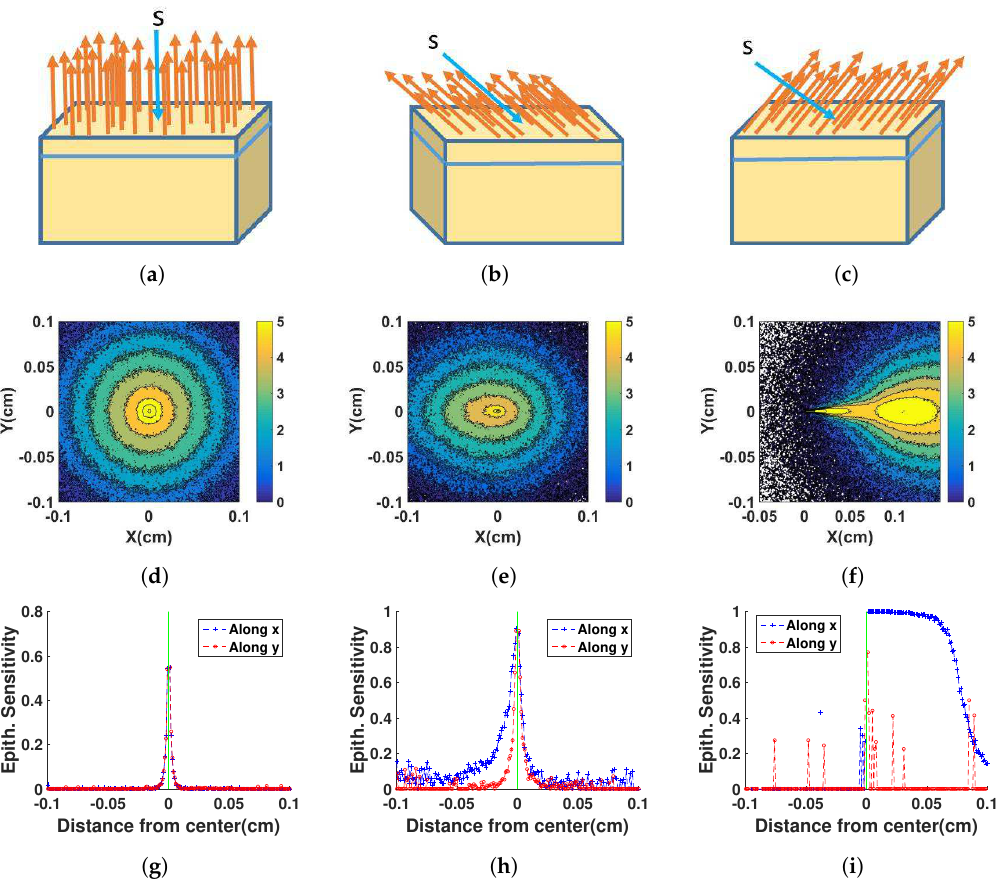
Figure 2. probe geometry-( a ) I, ( b ) II, and ( c ) III. In each of the three geometries, the blue arrow shows the launching direction of photon and orange arrows indicates the axis of collection of photons for SRR measurement. ( d – f ) show the 2-dimensional collection of SRR, and ( g – i ) show the epithelial sensitivities along the x-axis and y-axis for probe geometries-I, II, and III respectively. Width of the green region at the center of each of the plots ( g – i ) indicates the size of the source (color online